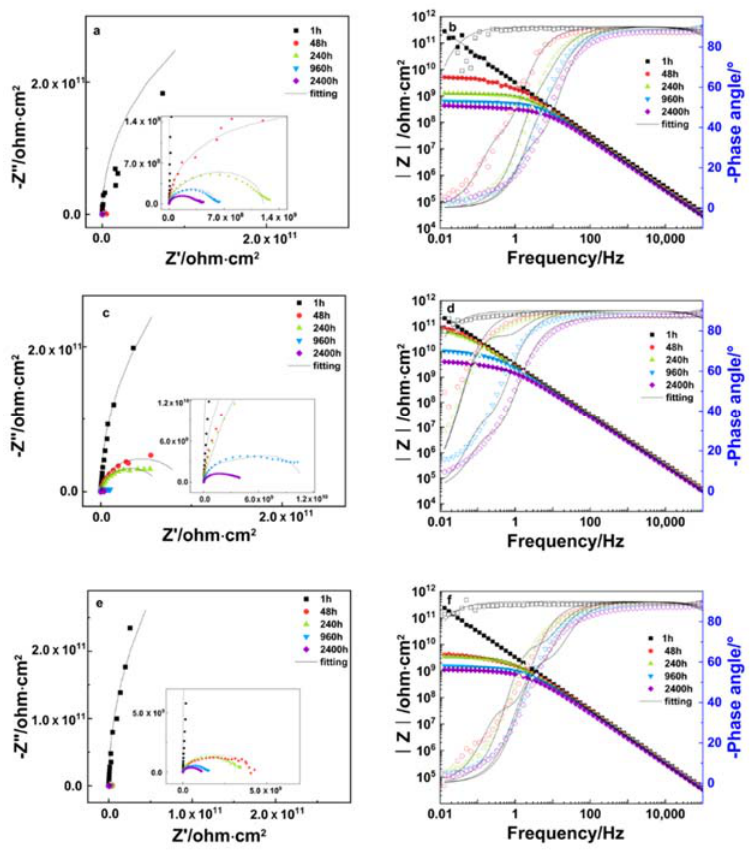
Figure 6. EIS spectra of three kinds of coatings. ( a,b )—PANI; ( c,d )—PAGO; and ( e,f )—PMGO.